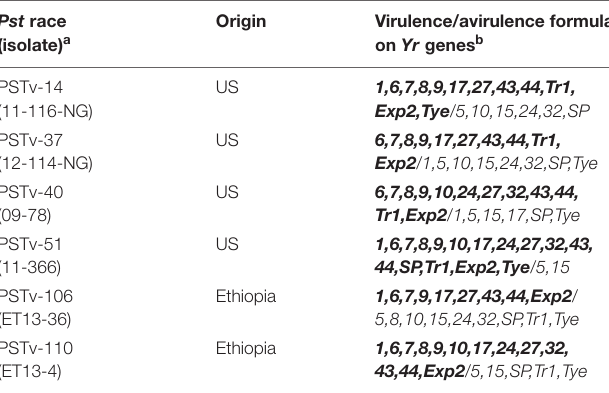
TABLE 1 | Puccinia striiformis f. sp. tritici ( Pst ) races used for seedling tests under controlled greenhouse conditions. Pst race (isolate)